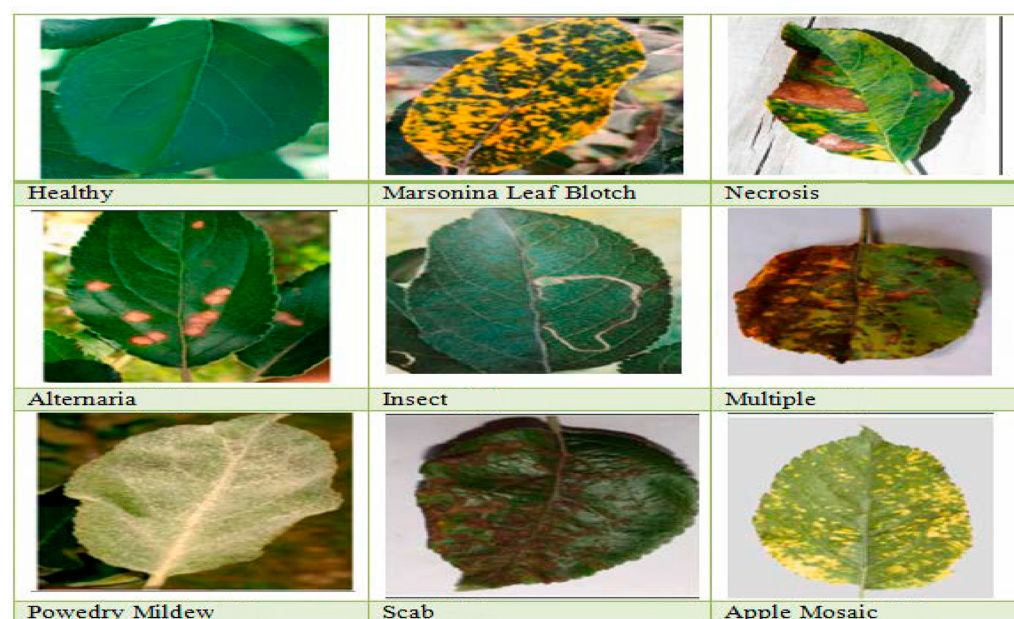
Figure 1. Diseases that Affect Apple Leaves, by Types